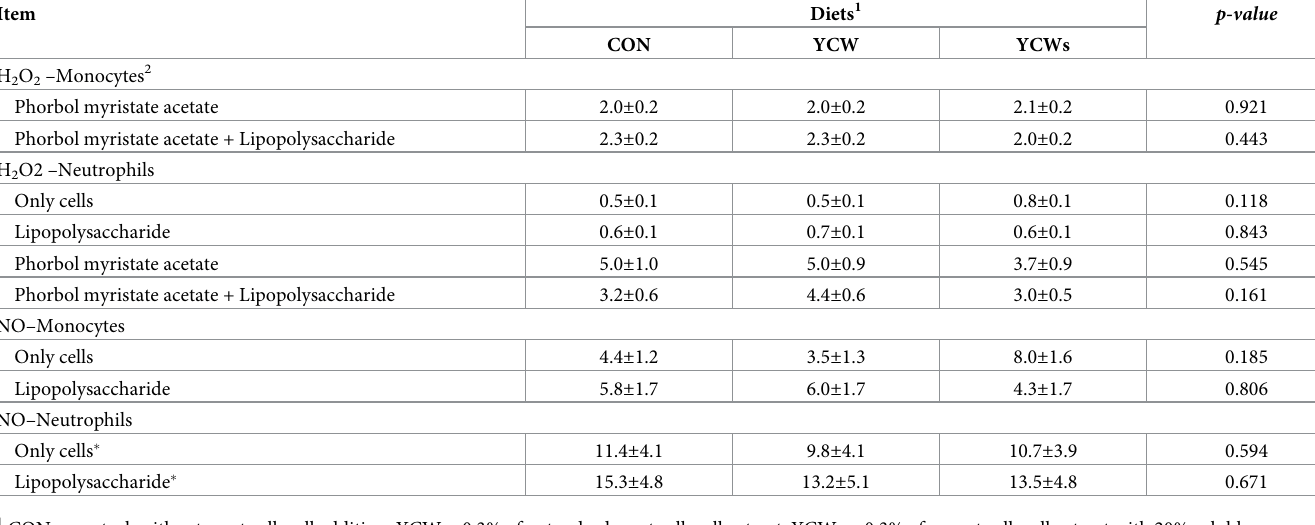
Table 9. Hydrogen peroxide (H 2 O 2 ; μ M of H 2 O 2 /2x10 5 cells) and nitrogen oxide (NO; μ M of NO/2x10 5 cells) production in cell cultures of monocytes and neutro- phils from the peripheral blood of dogs fed diets with the addition of different yeast cell wall preparations (mean and standard error of the mean).